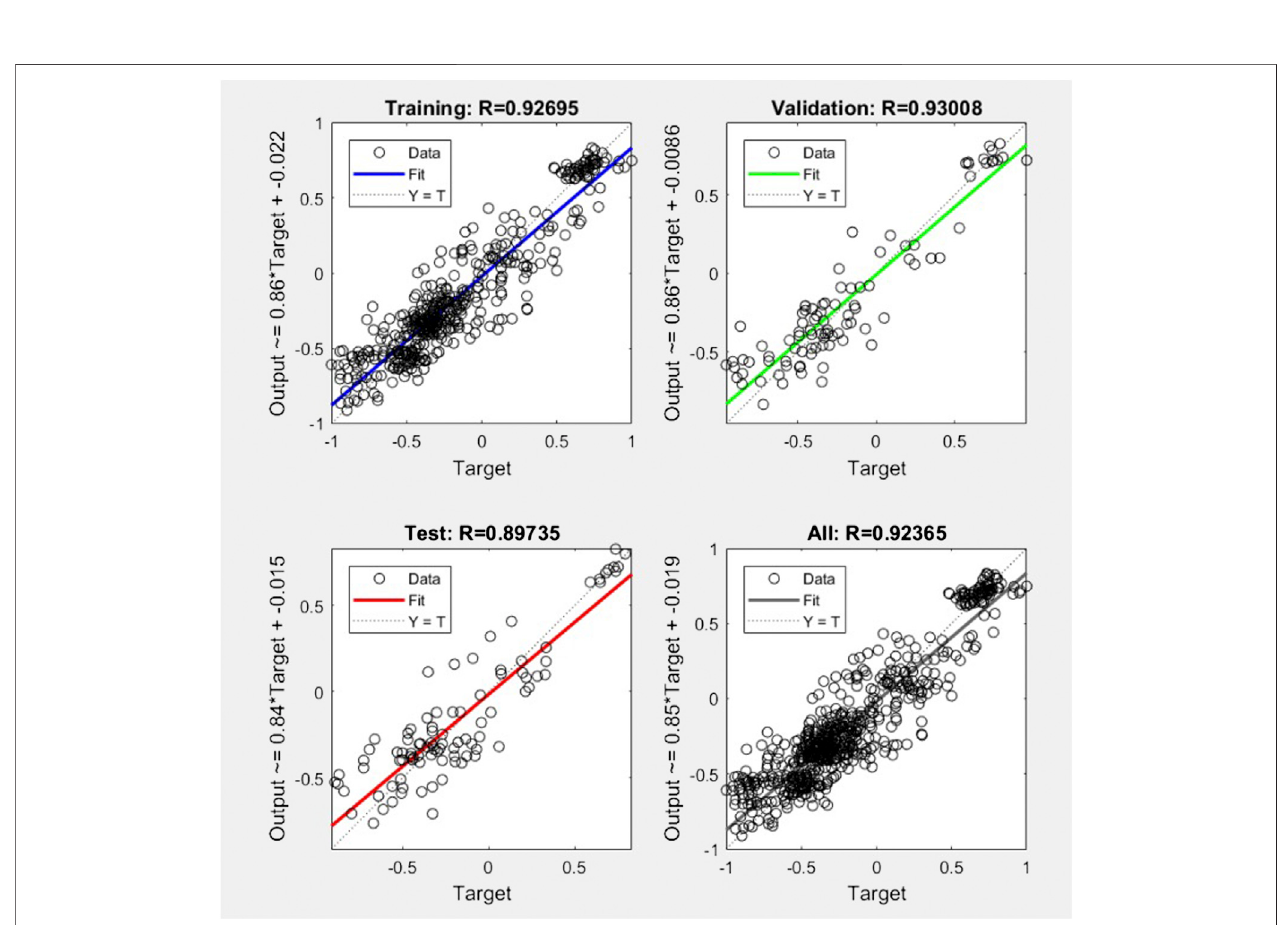
FIGURE 2 | Description of carbon price prediction fi tting in Fujian